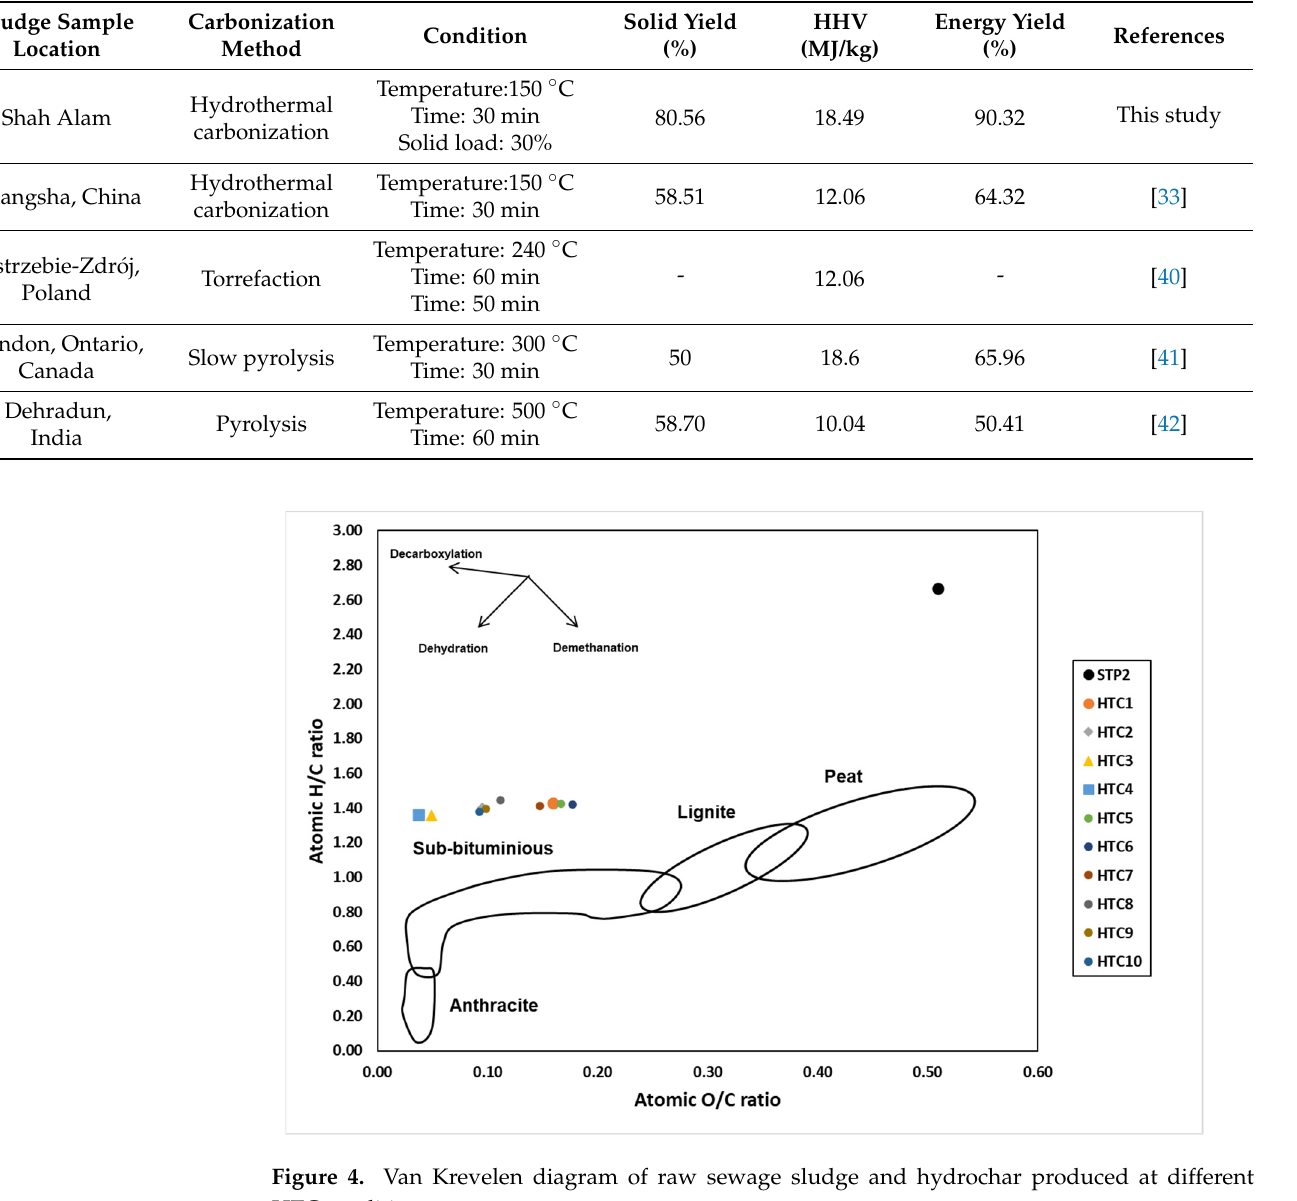
Table 5. Comparison of HHV of hydrochar/biochar under different operating parameters and carbonization method.